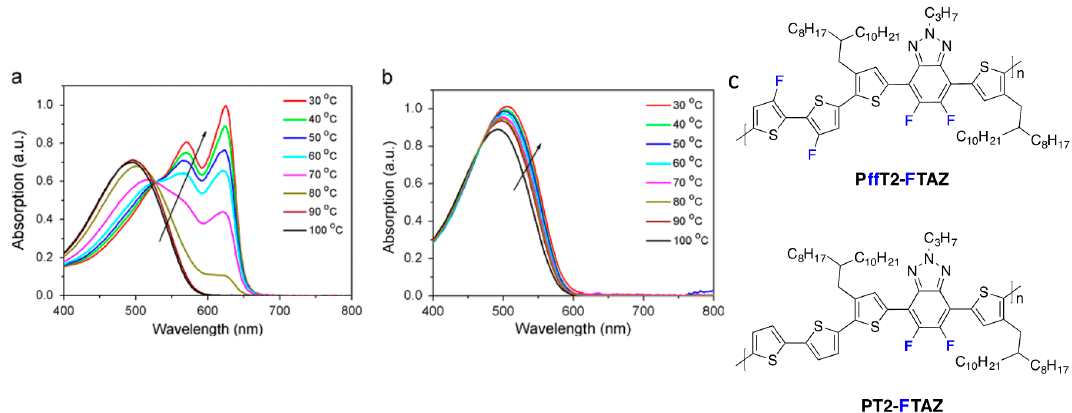
Figure 2. ( a ) UV–vis absorption spectra evolutions of PffT2-FTAZ in dichlorobenzene solution (cooling process, from 100 to 30 °C); ( b ) UV–vis absorption spectra evolutions of PT2-FTAZ in dichlorobenzene solution (cooling process, from 100 to 30 °C); ( c ) Chemical structures of the fluorinated copolymers (adapted with permission from [32]; Copyright 2015 Elsevier).